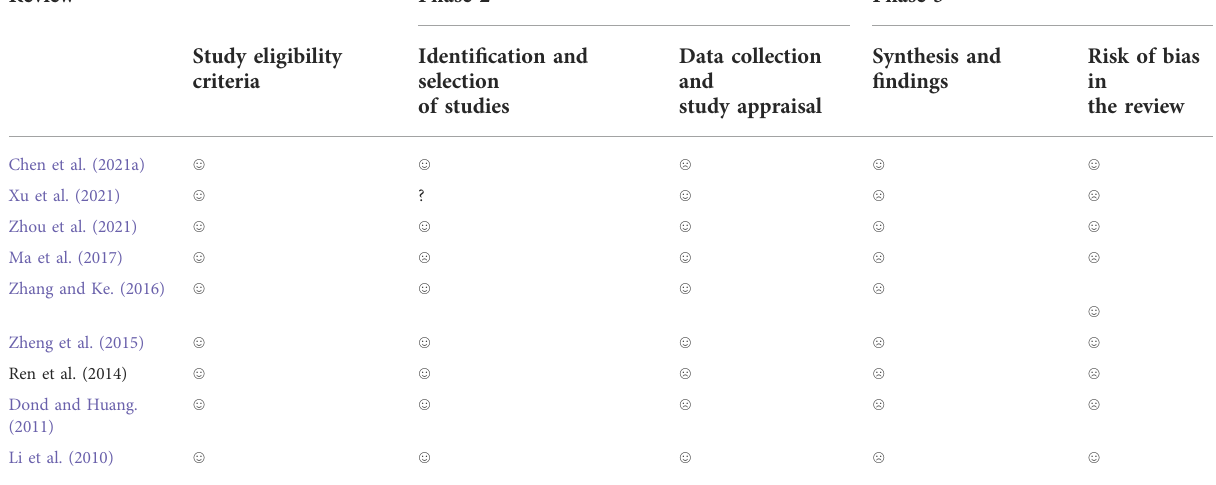
TABLE 5 Tabular presentation for ROBIS